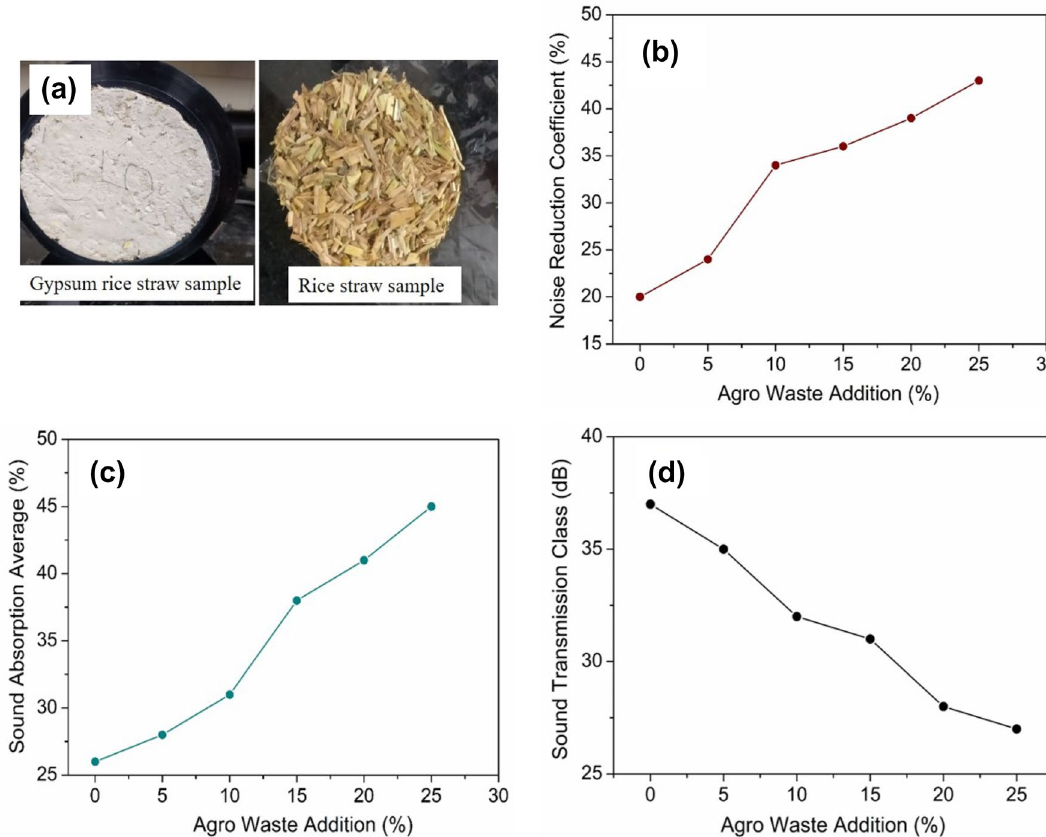
Figure 8. ( a ) Agro-waste gypsum samples for sound absorption and STL measurement; ( b ) ( c ) Noise reduction and Sound absorption average coefficients of various agro-waste gypsum samples; ( d ) Sound transmission class of various agro-waste gypsum samples.